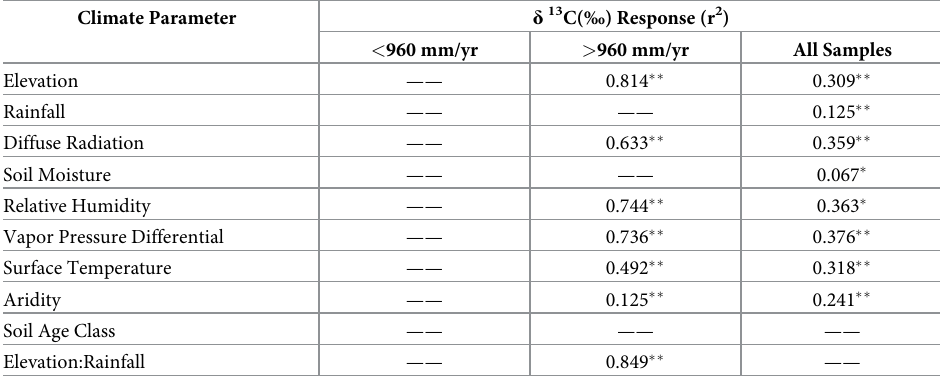
Elevation:Rainfall —— —— Correlation as represented by r 2 values; samples represented subsets above and below the identified threshold in annual rainfall of 970 mm/yr, and for all samples; � indicates p values < 0.05,